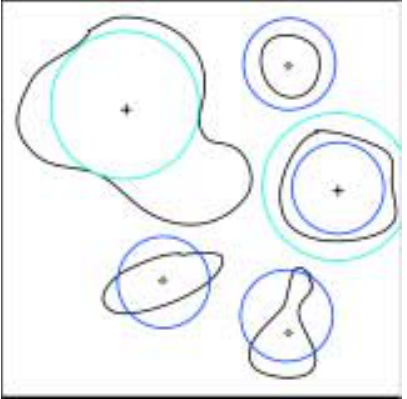
Fig.5. Selection criteria for objects via erosion and dilation by neces- sary inscribable circle (+) and deletion by erosion ( ∗ ). This figure can be viewed on http://www.esacp.org/acp/2003/25-1/rodenacker.htm.